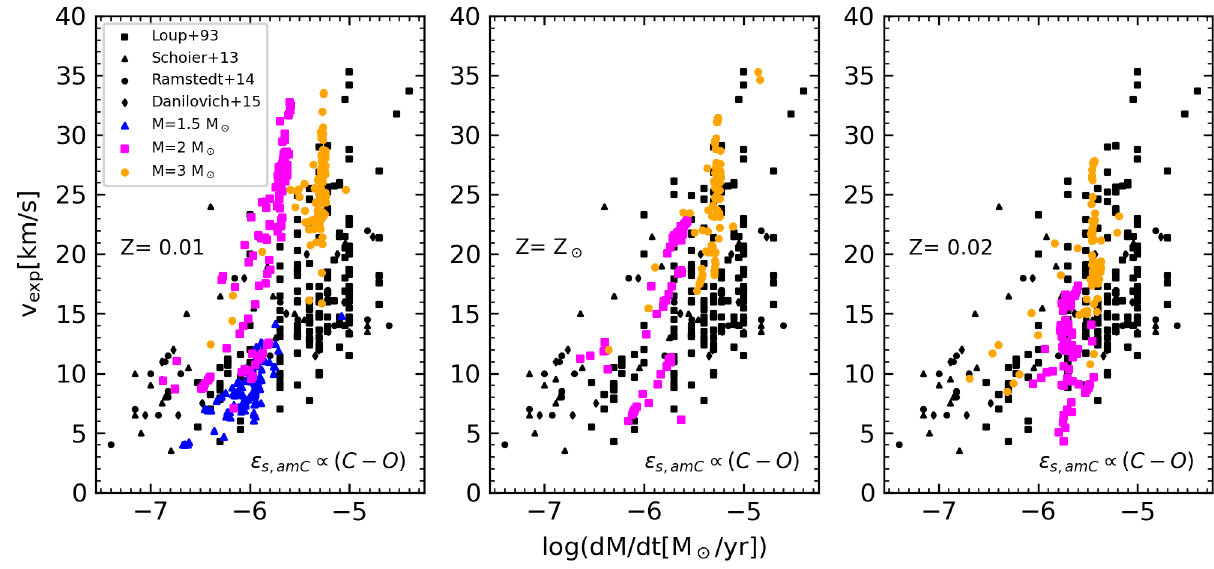
Figure A1. Comparison between observed and predicted expansion velocity vs. the mass-loss rate for metallicity represen- tative of the Galaxy. Black points are the quantities derived from the observations. The seed particle abundance for amC is proportional to the carbon excess (Choice (a) in Table